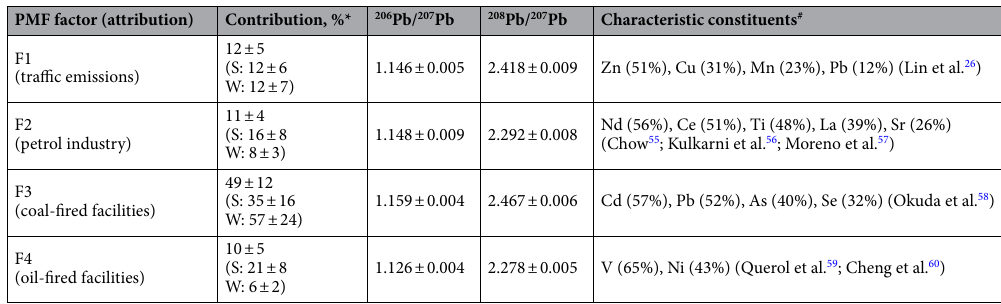
Table 2. Summary of source apportionment for Pb in PM 2.5 and Pb isotopic composition of the respective source factors resolved by the PMF model. *Averages for summer (S) and winter (W) campaigns are listed in parentheses. # The percentage of variations in the characteristic elements attributed to each PMF factor is listed in